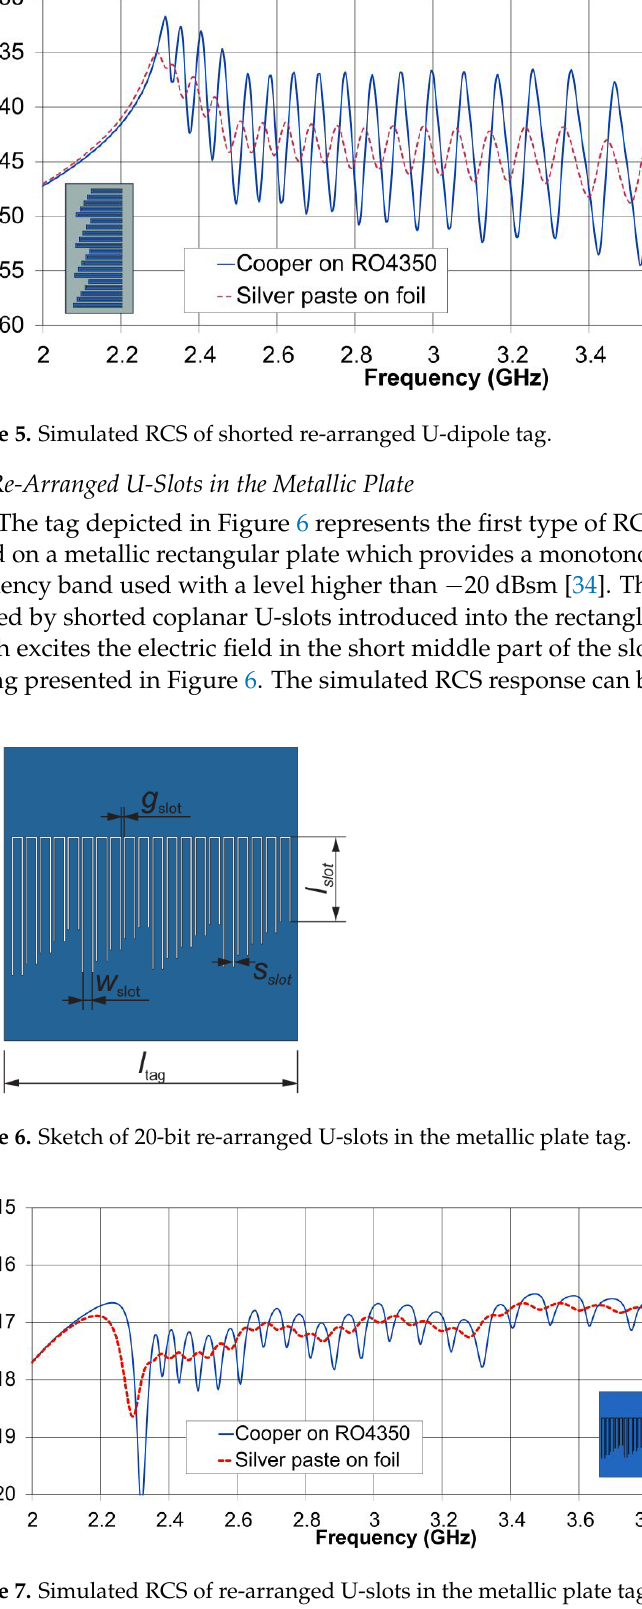
Table 1. Dimensions of shorted re-arranged U-dipole.